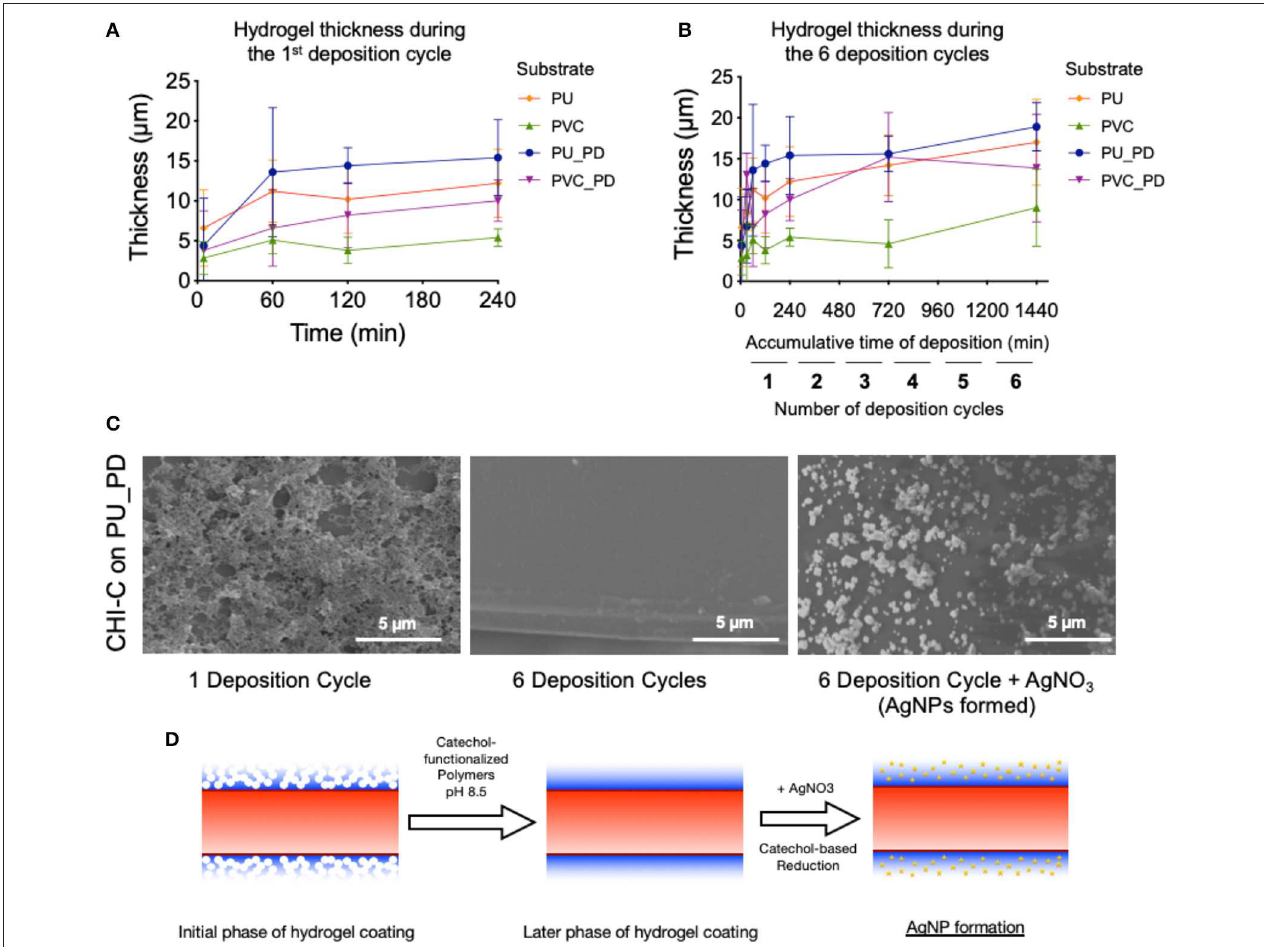
FIGURE 2 | Fabrication and surface morphology of CHI-C hydrogel coatings on urinary catheter materials. (A,B) Changes in the thickness of the CHI-C hydrogel coating during (A) the first 4-h deposition cycle (B) during 6 deposition cycles (4h each). (C) SEM images of the CHI-C hydrogel coated PU substrates fabricated using 1 deposition cycle (left panel), 6 deposition cycles (middle panel), and 6 deposition cycles treated with AgNO 3 to form AgNPs (right panel). (D) Schematic representations of the CHI-C hydrogel coating formation using the dip coating method in oxidative environment.